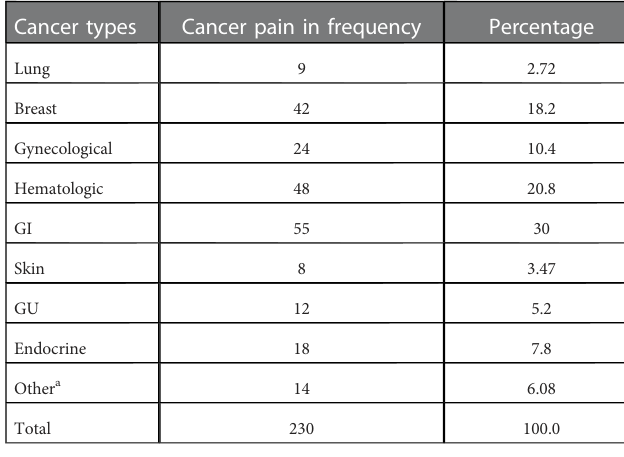
TABLE 3 The proportion of cancer pain in each cancer type among patients attending the oncology unit of UoGCSH, Northwest Ethiopia 2021 ( n =230). Cancer